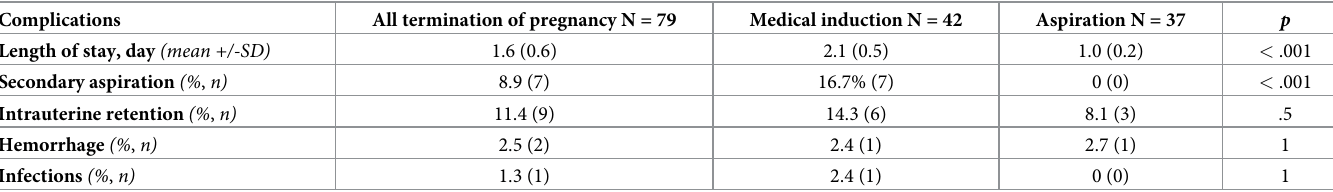
Table 6. Maternal complications globally and by method of